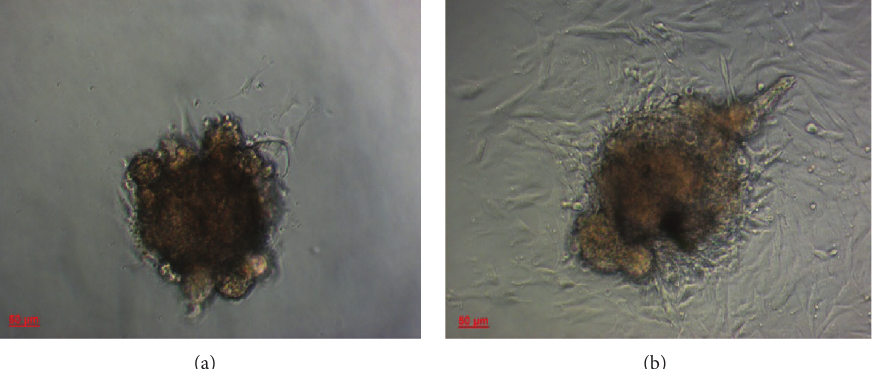
Figure 1: (a) Some stellate shape-like cells began to grow out of four-month-old GK rat islets after 48 h of culture. (b) These cells exponentially proliferated and migrated out from the islets after 72h, at 100x magnification ( 𝑛 = 3 ).